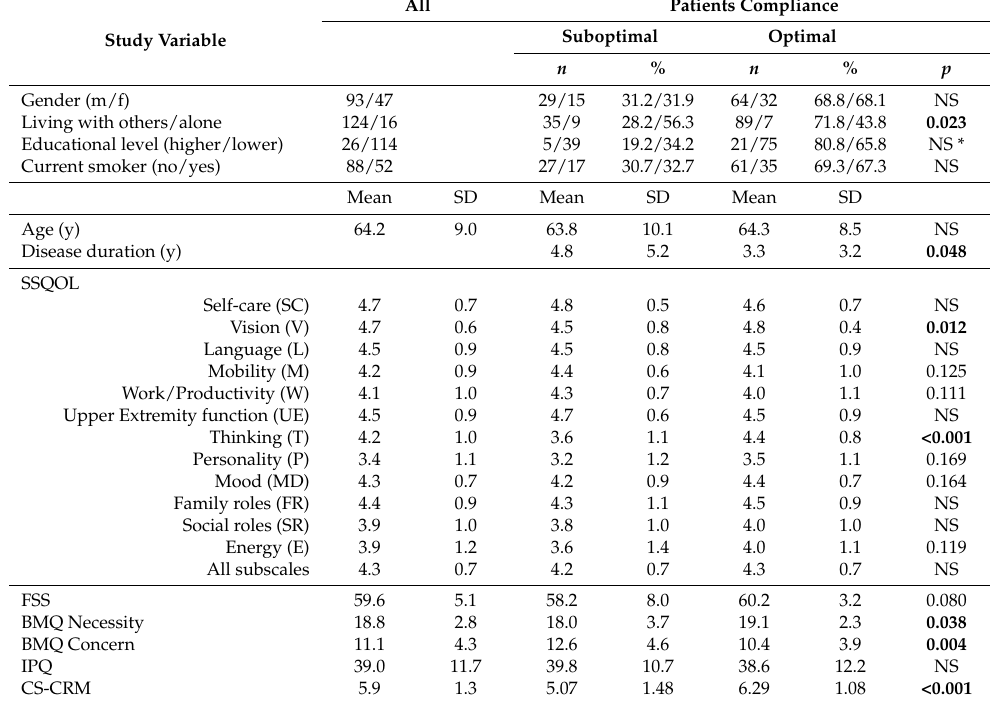
Table 2. Study variables and its relationship with